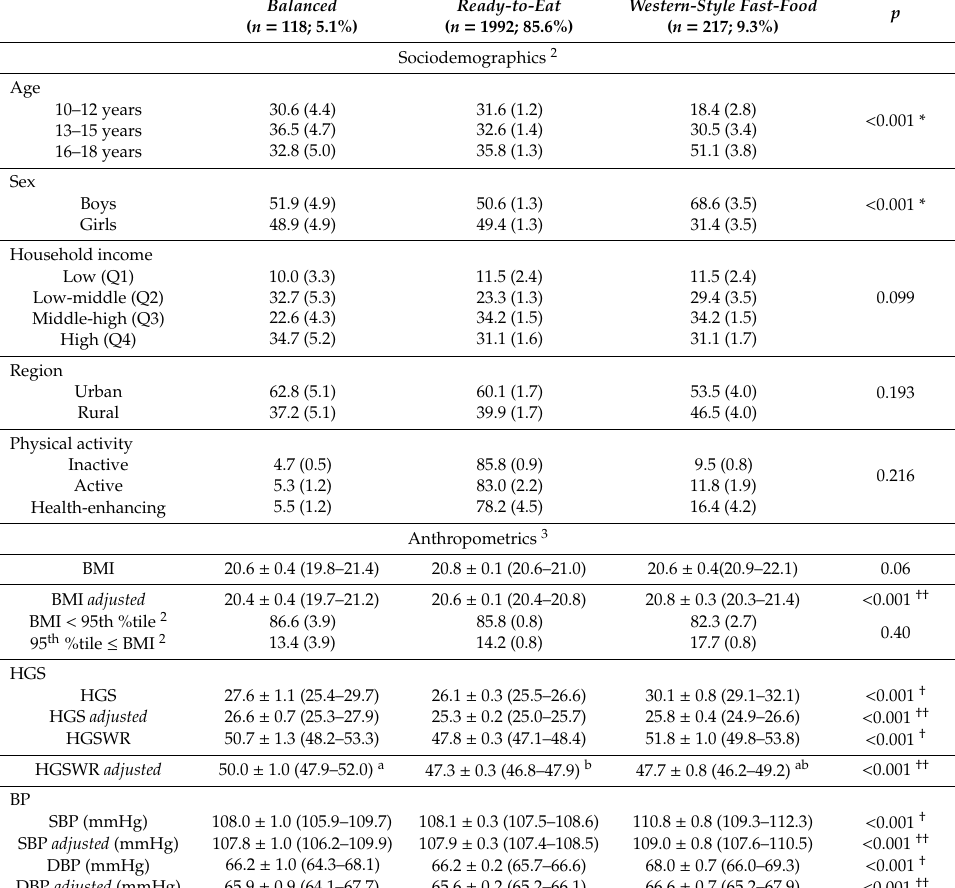
Table 1. General characteristics of 10–18-year-old children and adolescents according to the three dietary patterns 1